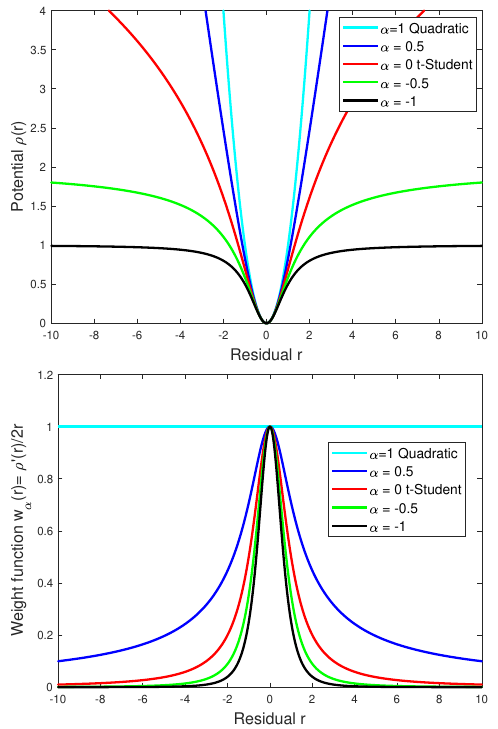
Figure 3. SEF potential (top) and weight (bottom) functions, as introduced in (Tarel et al., 2002)